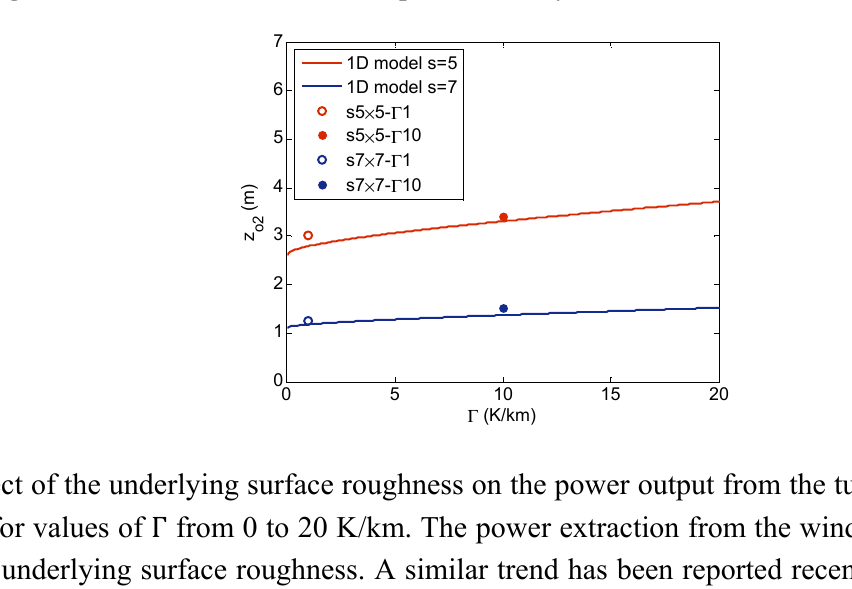
Figure 15. Influence of free-atmosphere stability on wind farm effective roughness.